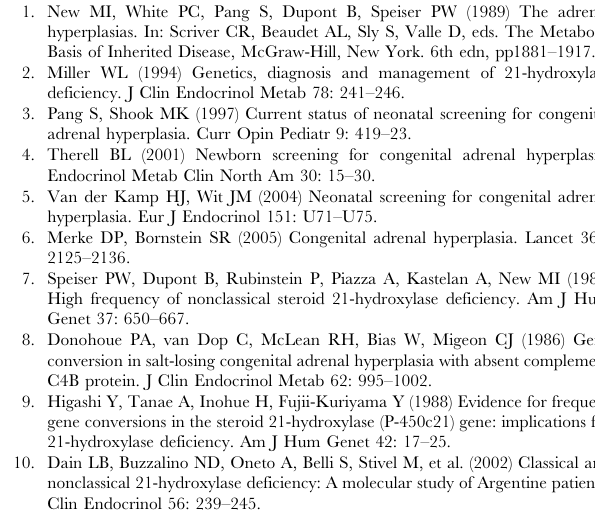
Figure S2 Correlation between experimental activities and predicted stabilities for both models. Residues known